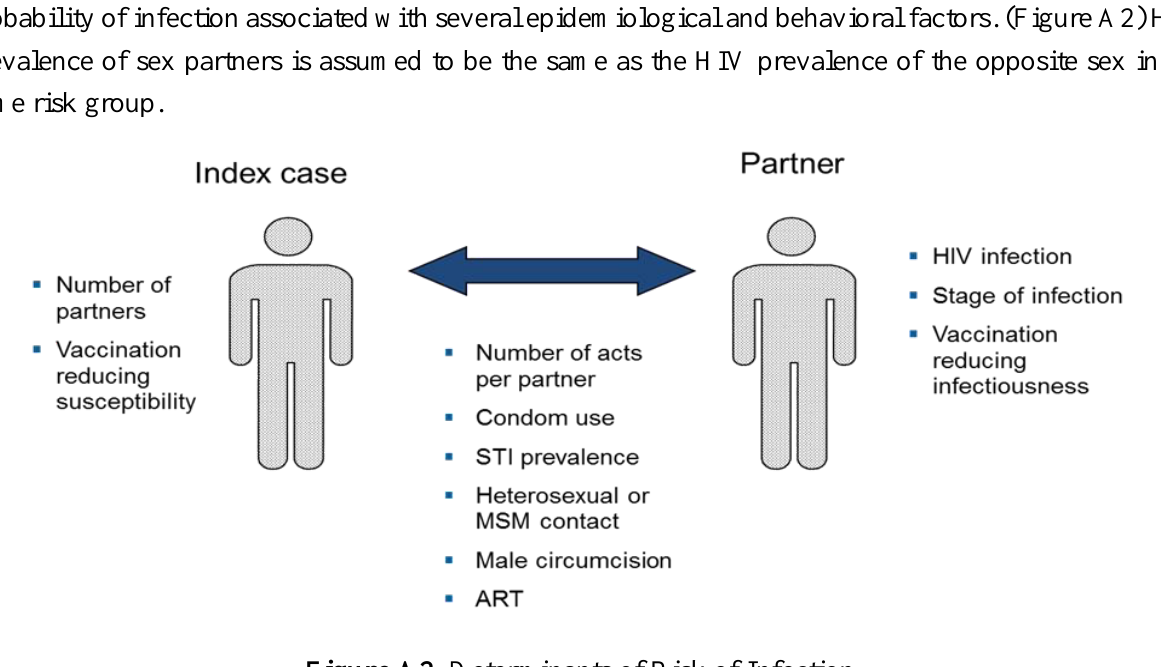
Figure A1. Model Risk Structure.